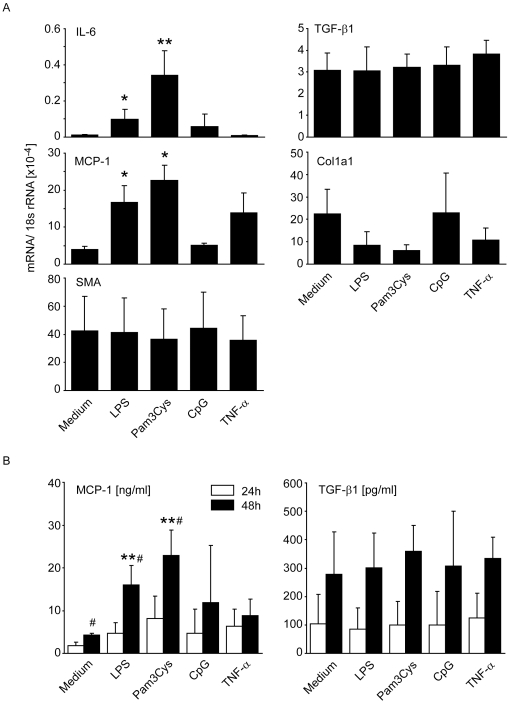
TLR-induced expression of cytokines and profibrotic mediators in renal fibroblasts.CD90+ fibroblasts were prepared from mice and cultured as described in methods. The cells were stimulated with 1 ug/ml of either Pam3Cys lipopeptide (TLR2 agonist), LPS (TLR4 agonist), CpG-DNA (TLR9 agonist) or 5 ng/ml TNFα. A: After 24 hours of stimulation cell mRNA was isolated and quantified by real-time PCR and refered to the respective 18S rRNA level. Data represent means ± SEM from three independent experiments. * p<0.05 versus medium. B: Renal fibroblasts were stimulated as before and cell culture supernatants were obtained after 24 (white bars) and 48 hours of stimulation (black bars). MCP-1 and TGF-β levels were measured by ELISA. Data represent means ± SEM from three independent experiments. * p<0.05 versus medium.